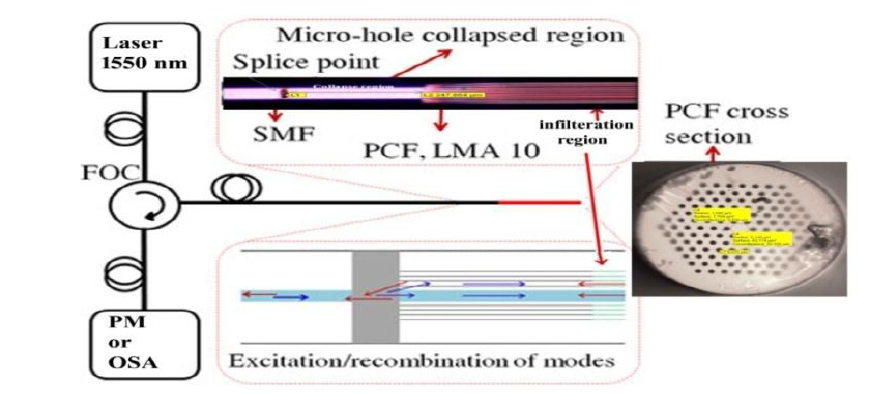
Fig. 1: Schematic of the humidity sensor